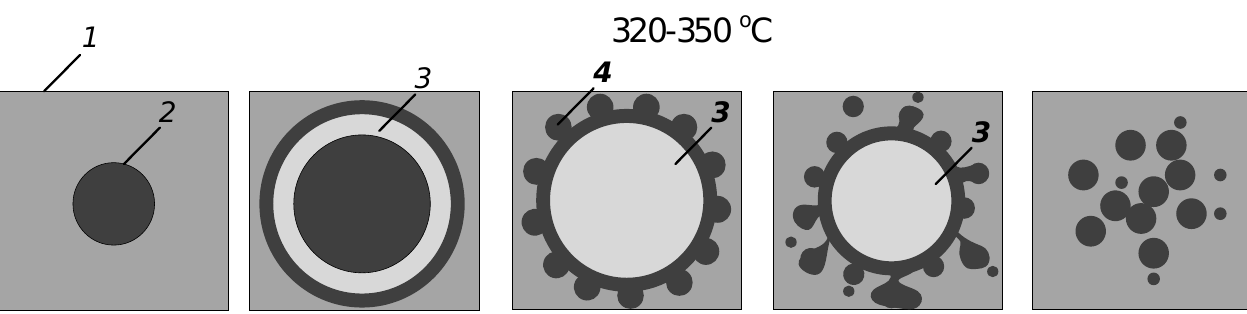
Figure 8. Wall impact regime map (top view): 1 — substrate; 2 — droplet; 3 — liquid film; 4 — crown formation.